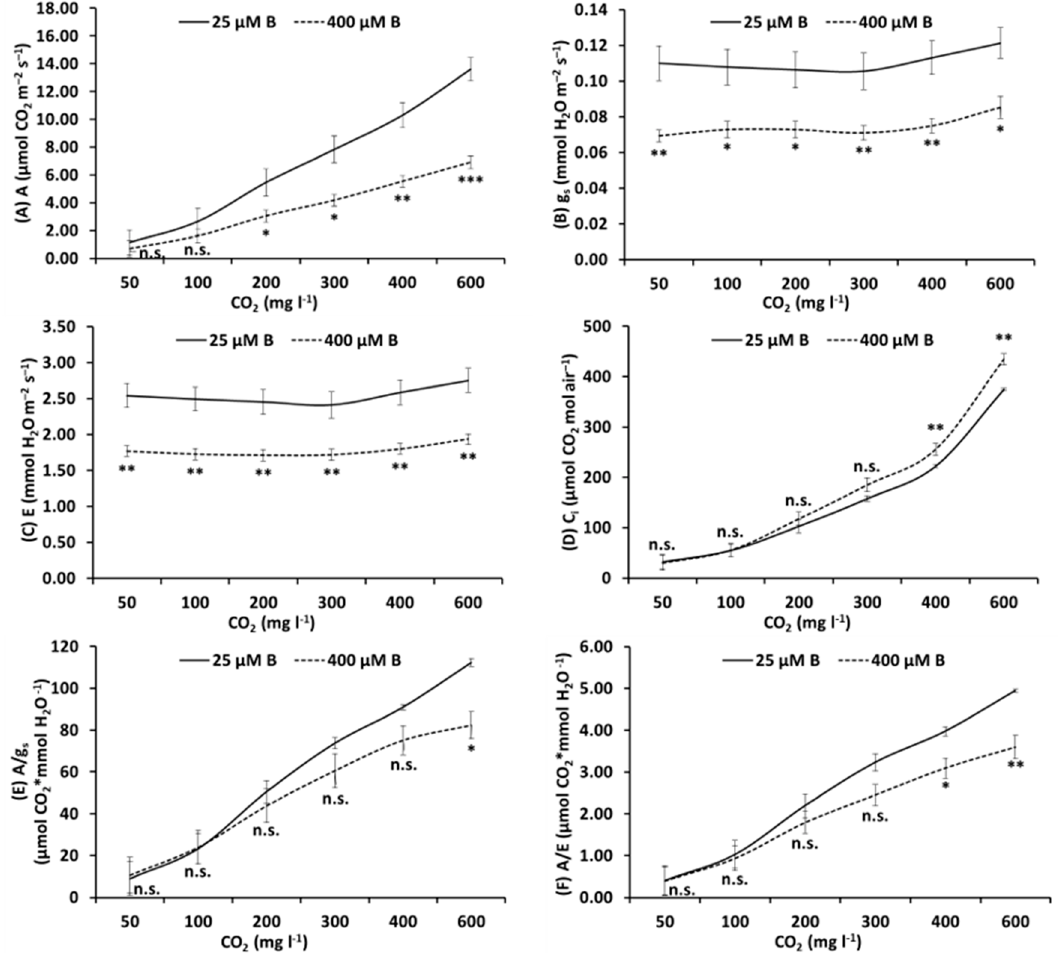
Figure 2. Net photosynthesis (A; μ mol CO 2 m –2 s –1 ) ( A ), stomatal conductance (g s ; mmol H 2 O m –2 s –1 )